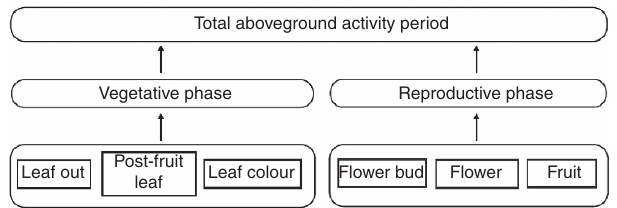
Figure 1 | Diagram of hierarchical phenological events measured in this study. Each phenological event was measured as the number days from start to end, or the duration of the event. The vegetative phase is the sum of the duration of individual-level vegetative events that occur before and after the reproductive phase. The activity period refers to the total length of the aboveground activity